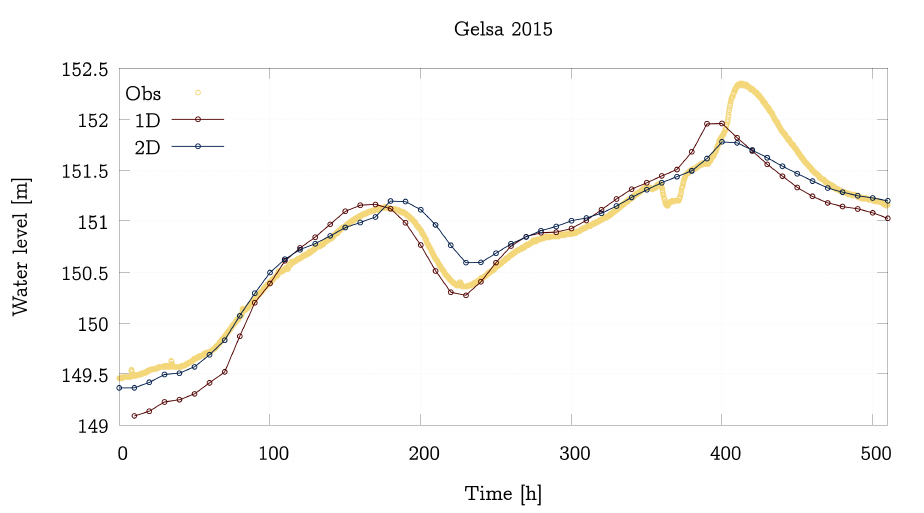
Figure 8. Water level temporal evolution comparison between 1D model, 2D model and observation data at Gelsa (A263) gauging station for the 2015